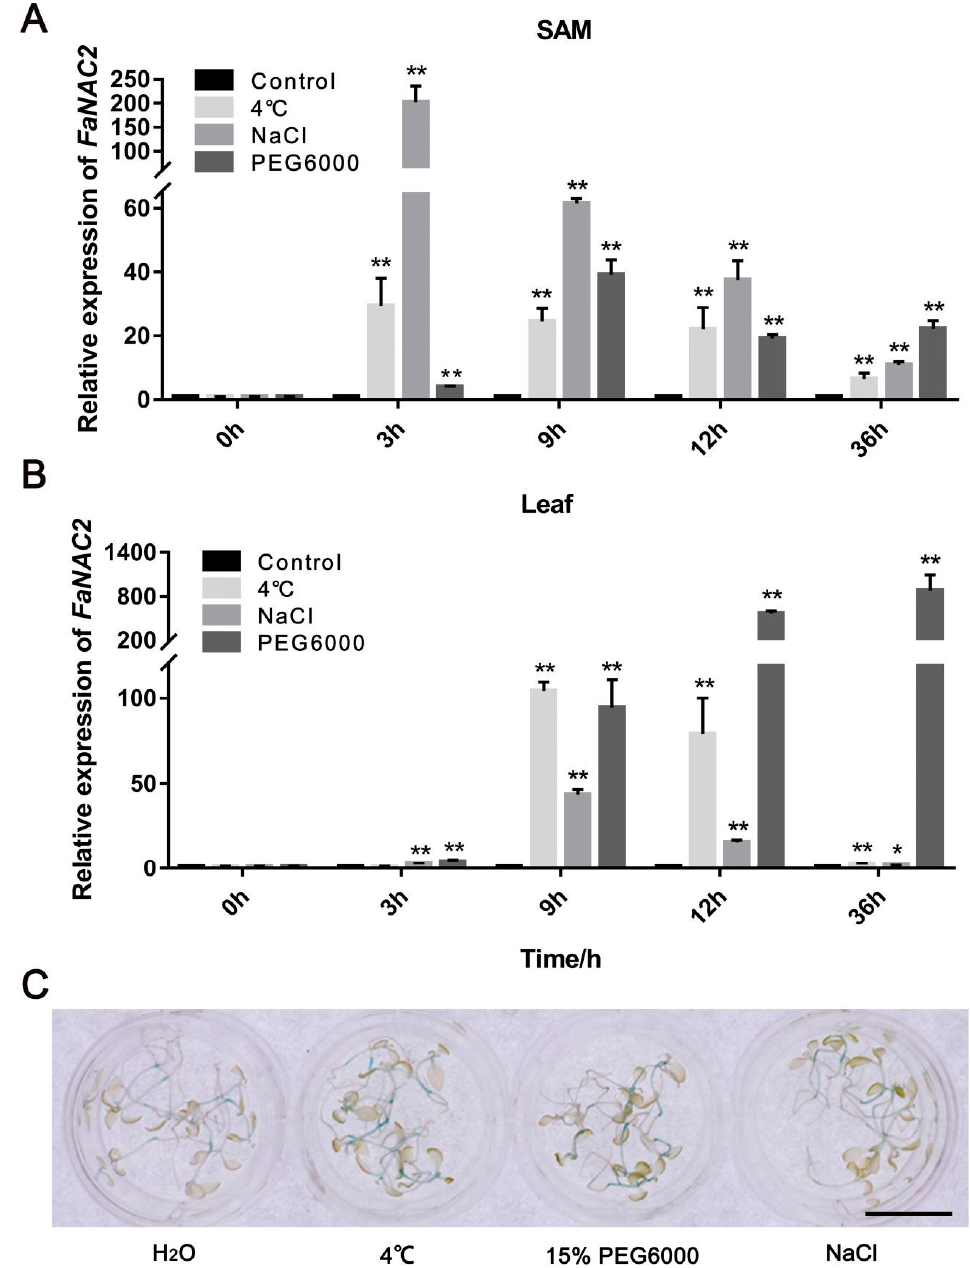
Figure 3. FaNAC2 is induced by cold, drought, and salinity stress. ( A ) The expression level of FaNAC2 in the SAM (shoot apical meristem) of strawberry under different abiotic stresses. ( B ) The expression level of FaNAC2 in the leaves of strawberry under different abiotic stresses. ( C ) Different abiotic stress treatments to 7 DAG (days after germination) Pro FaNAC2 –GUS seedlings. Salinity treatment used 200 mM NaCl. Three independent experiments were performed and error bars indicate standard deviation (Student’s t –test; * p < 0.05; ** p < 0.01). The scale bar represents 1 cm.